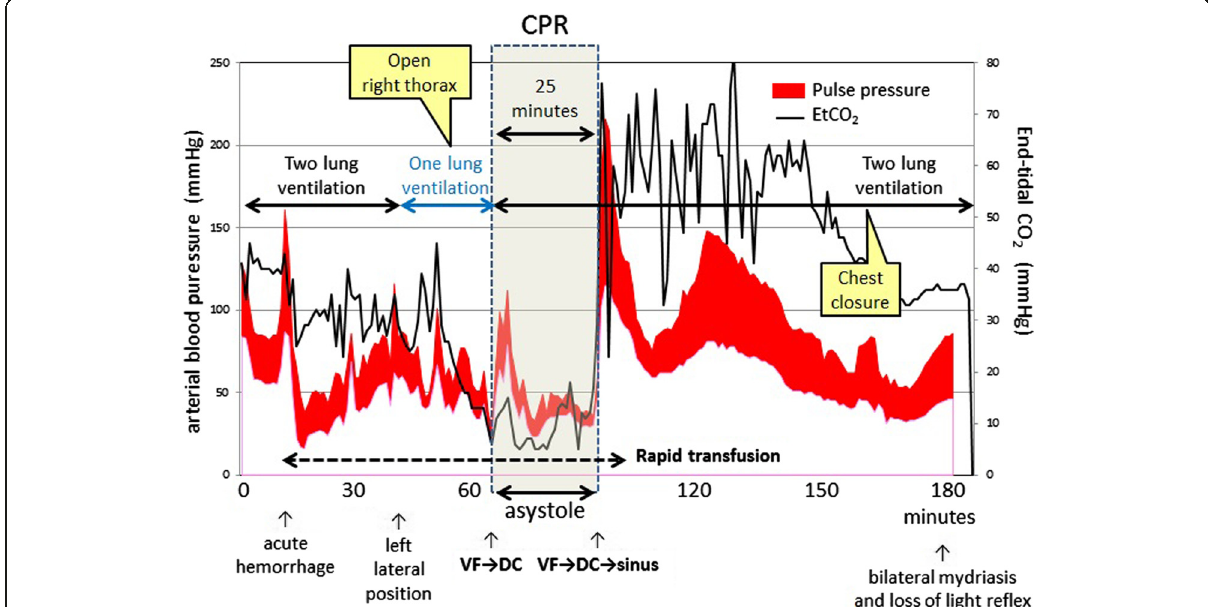
Fig. 2 Overview of the resuscitation from the beginning of acute hemorrhage to the chest re-closure. CPR was performed for 25 min in the left lateral position and with the right thorax